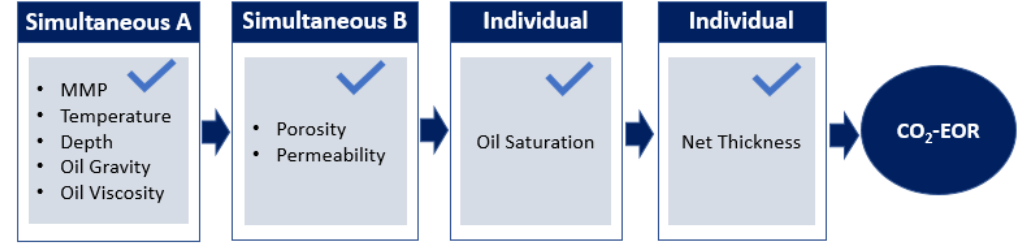
Figure 7. CO 2 -EOR simultaneous and individual combination screening model.